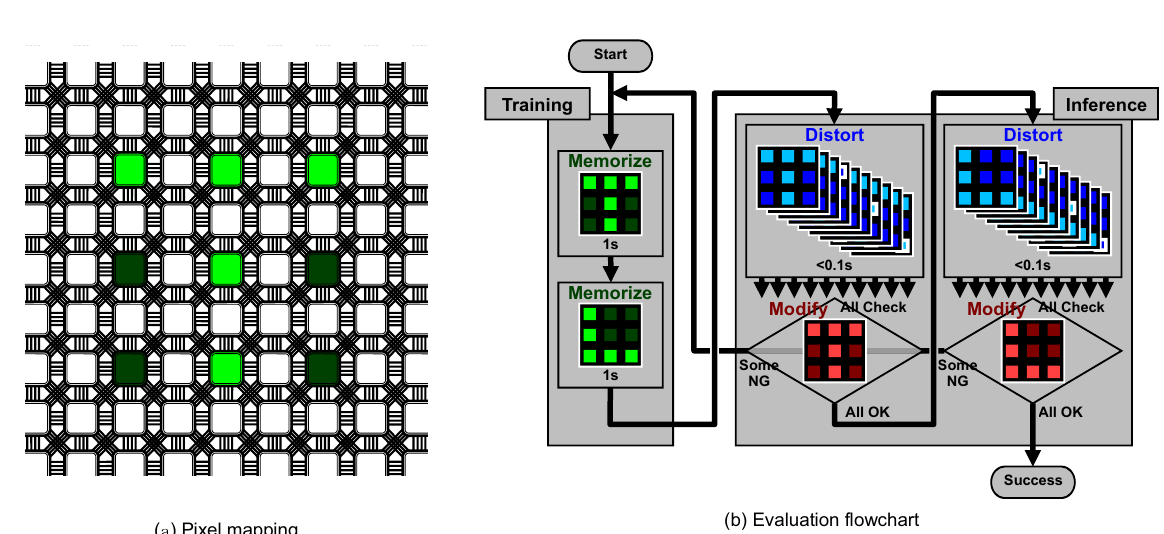
Figure 4. Neuromorphic chip integrated with an LSI and AOS thin-film synapse devices.